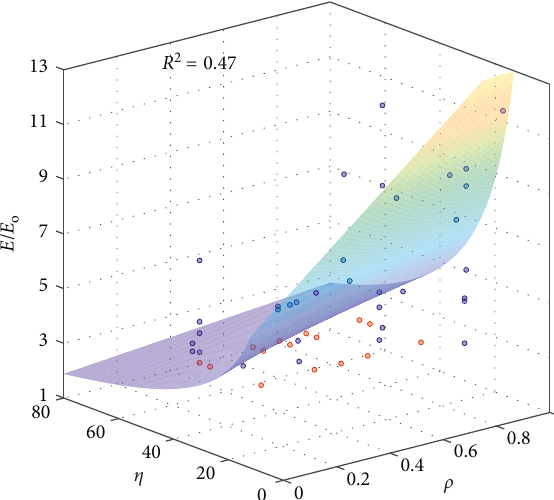
Figure 10: 3D figure of Equation (7) in terms of E / E / μ with the ε ε o experimental data (blue points) and the numerically simulated data (red points).